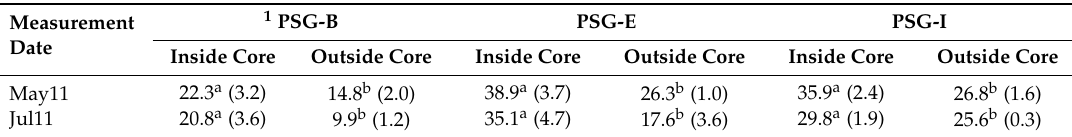
Table 2. Volumetric soil moisture content from 0 to 12 cm measured inside and outside cores in a four-year-old switchgrass and loblolly pine intercropping system on the lower Coastal Plain of North Carolina. Measurements inside cores were conducted in May and July only. Different letters indicate significant differences between inside and outside core moisture within a treatment at p < 0.05 based on a t -test. Means are followed by ± 1 standard errors in